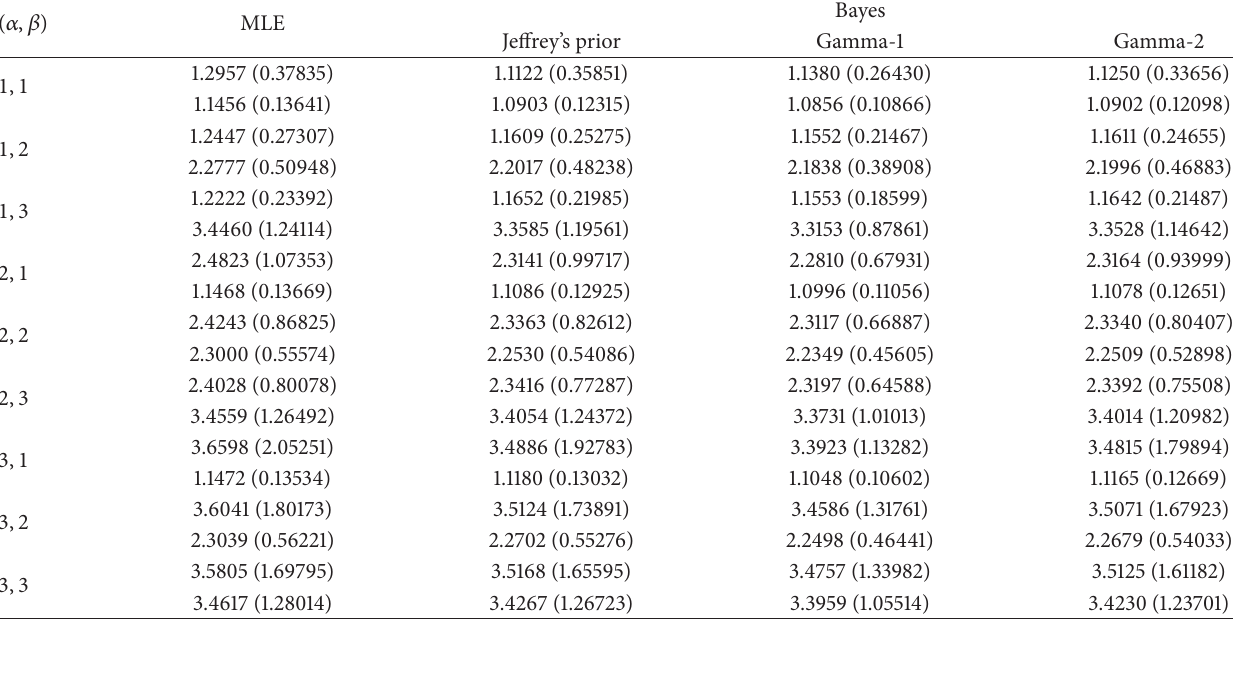
Table 4: Average estimates and MSEs (in the brackets) of the estimators of 𝛼 (in the first row of each cell) and 𝛽 (in the second row of each cell) for fixed 𝑛 = 20 , 𝑟 = 12 with varying